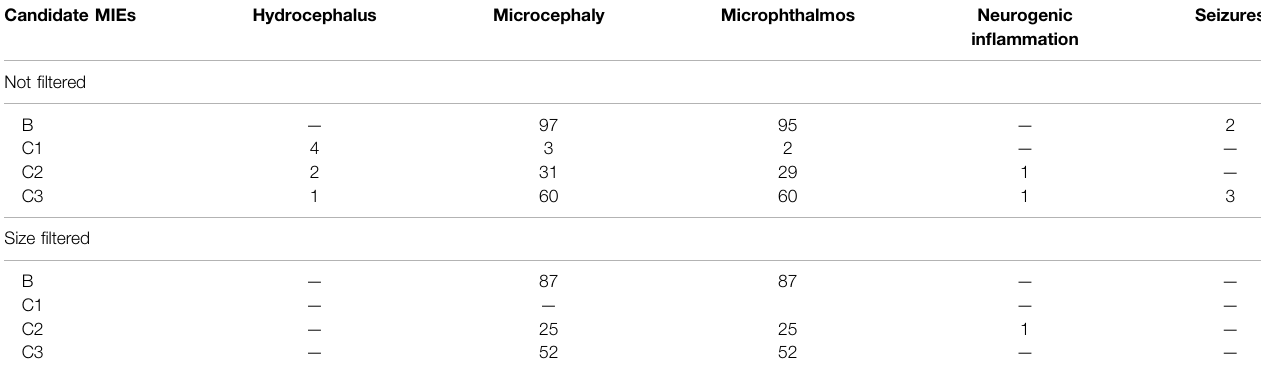
Frontiers in Toxicology |